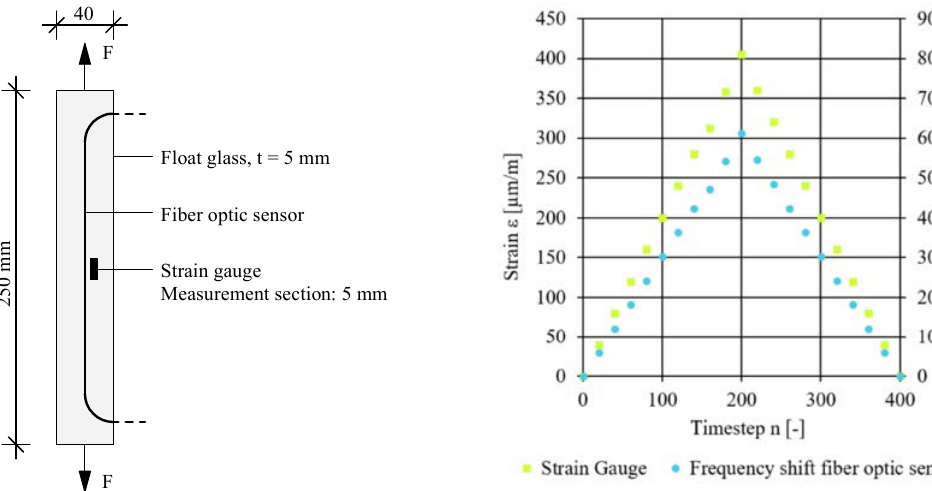
Fig. 2 Determination of the strain coefficient in the tensile test. Left: Test setup with fiber optic sensor and strain gauge. Right: Strain measured with strain gauge and associated frequency shift of the fiber optic sensor.